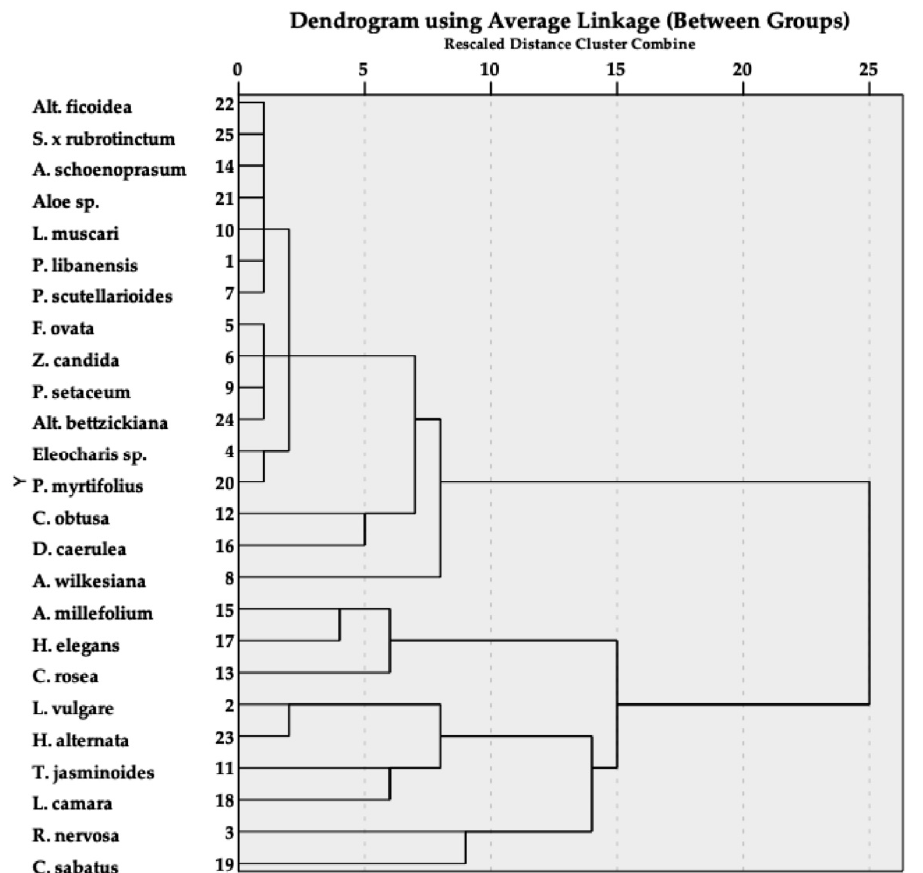
Figure 6. Cluster analysis of 25 ground cover species using multivariate parameters of leaf relative water content, aesthetic appeal, and percent stomata opening by Hierarchical cluster analysis of SPPS software. Horticulturae 2020 , 6 , x FOR PEER REVIEW